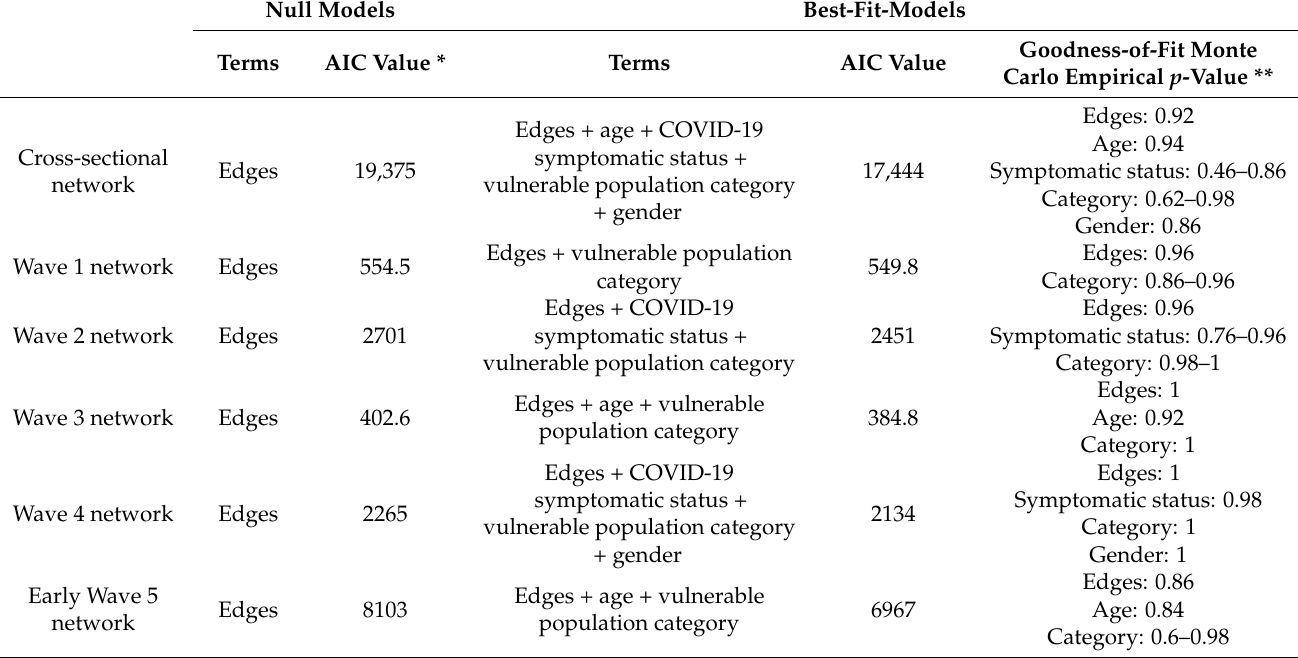
Table 5. Best-Fit-Models and Goodness-of-Fit. Null